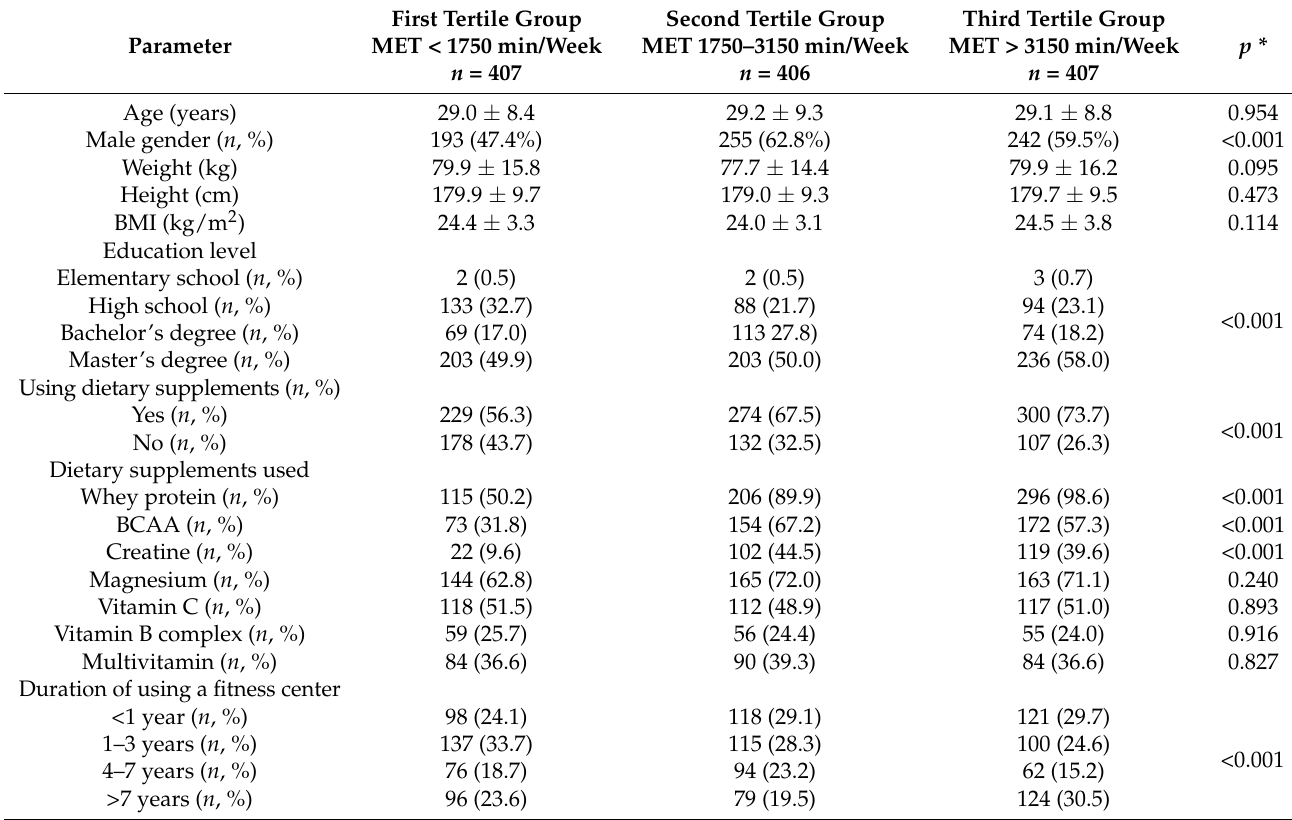
Table 2. Differences of the baseline characteristics between the tertiles of the IPAQ-SF